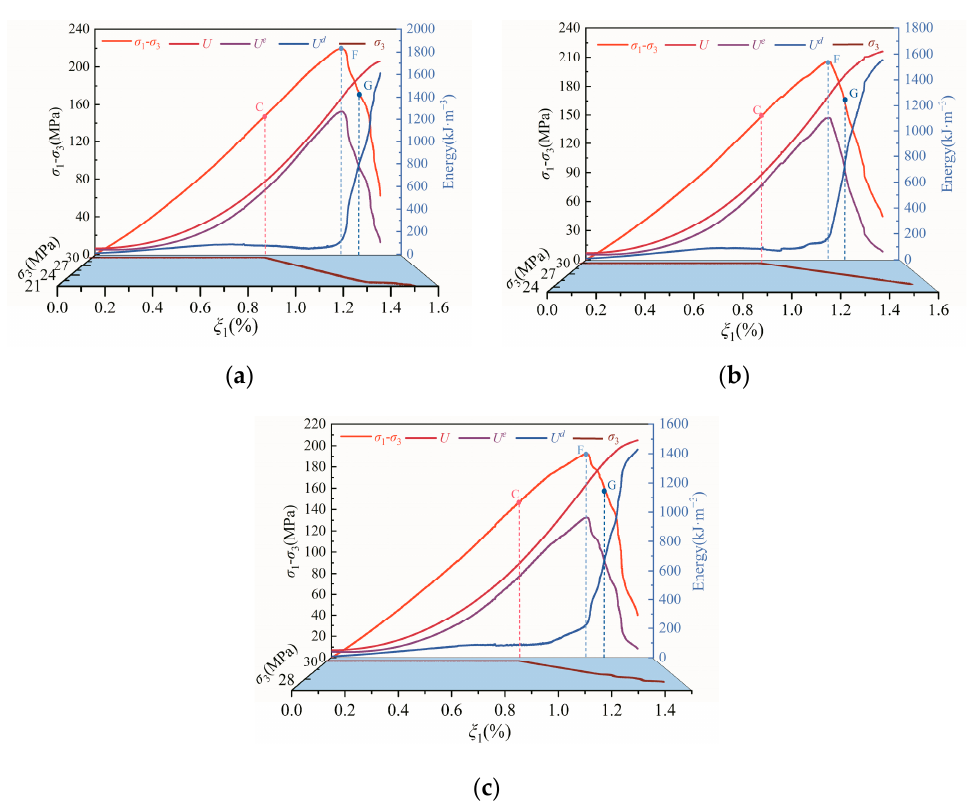
Figure 5. Energy evolution curves of diorite under different unloading confining-pressure rates: ( a ) ( a ) 0.008 MPa · s − 1 , ( b ) 0.016 MPa · s − 1 , and ( c ) 0.032 MPa · s − 1